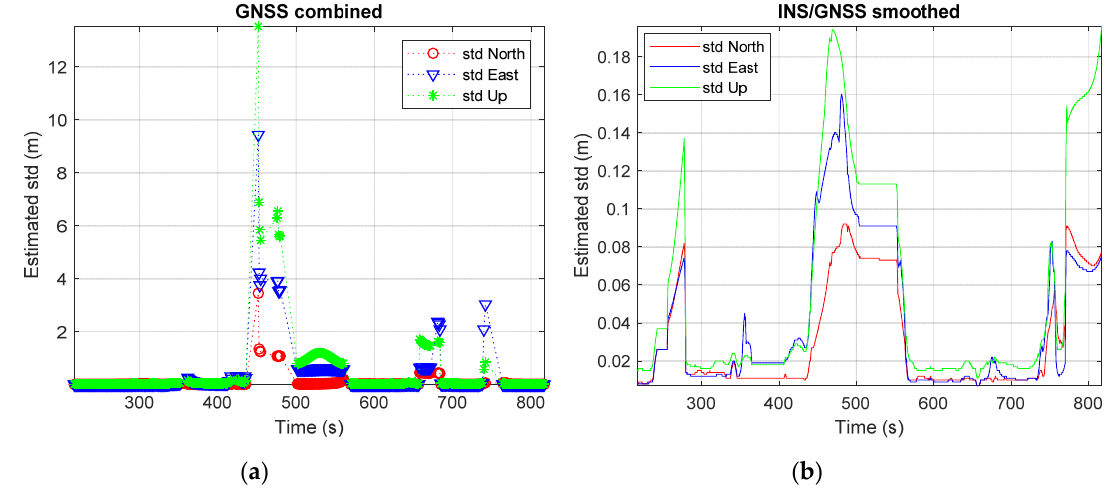
Figure 7. Estimated std from the first test: ( a ) GNSS-only solution; ( b ) INS/GNSS integration with smoothing solution.